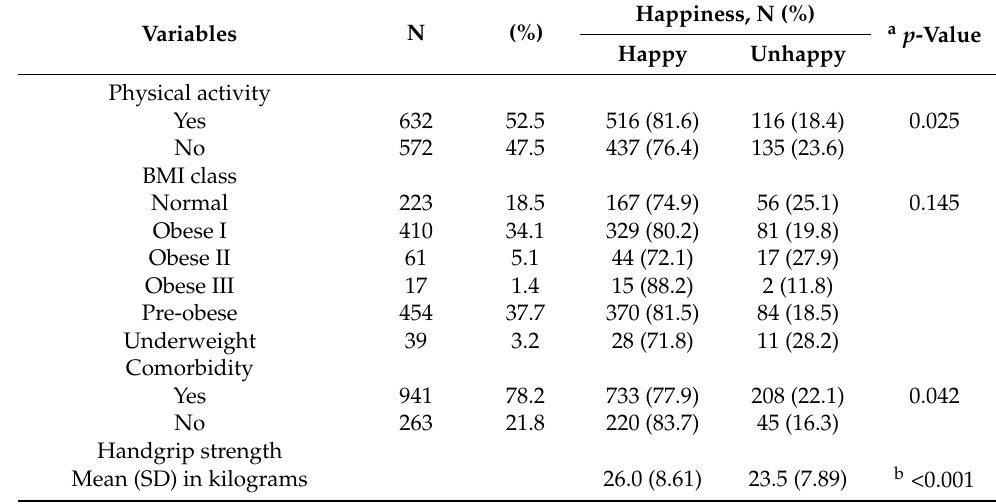
Table 2. Descriptive and bivariate analysis of health parameters associated with happiness.